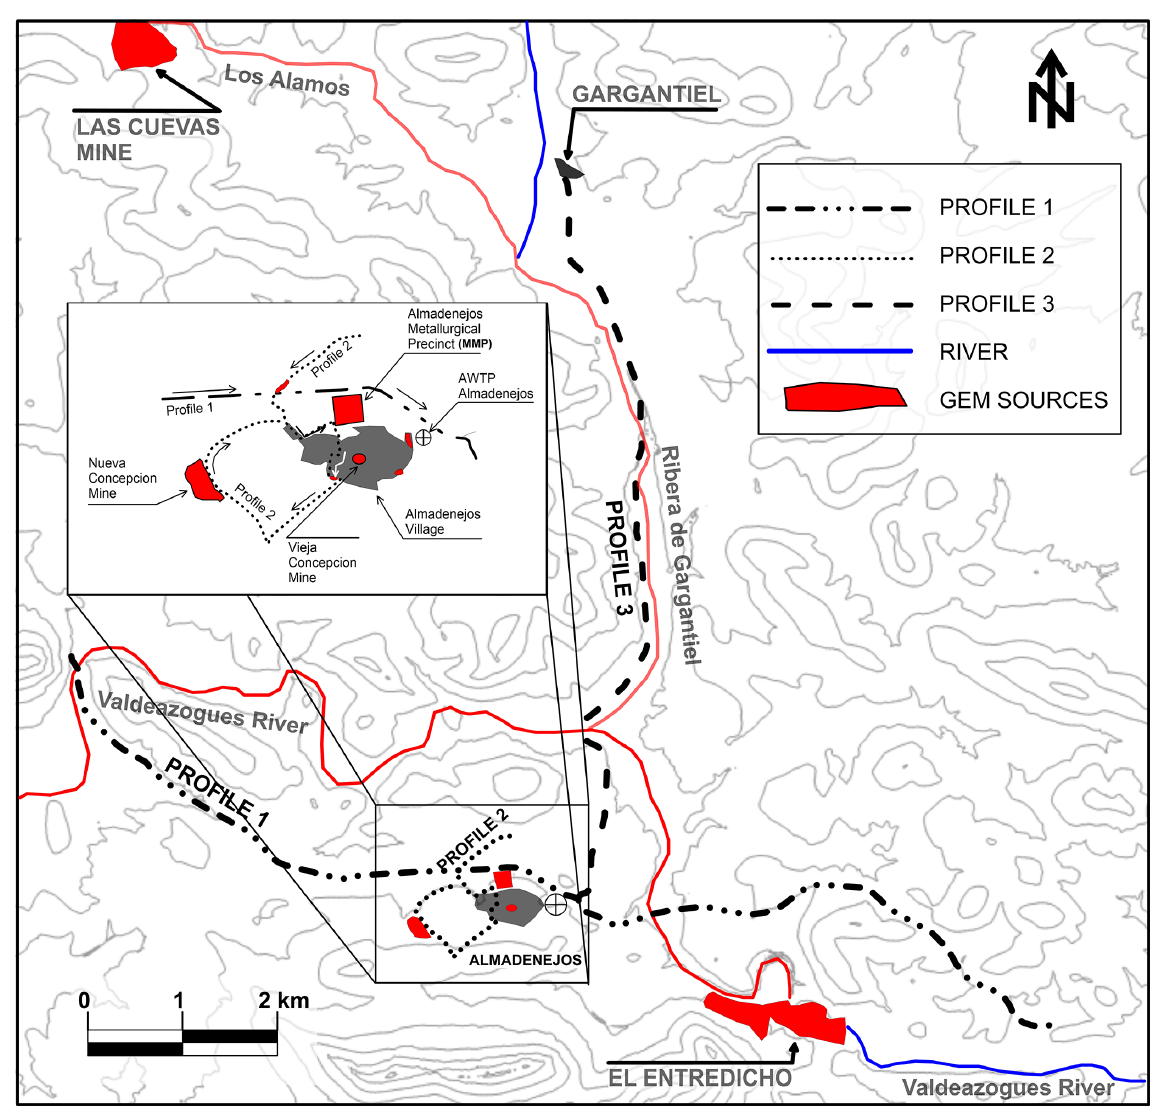
Figure 1. Location of the three horizontal profiles in the study area and main mercury mining sites. AWTP: Almadenejos wastewater treatment plant. Main known gaseous mercury sources are shown in red (including rivers with Hg-contaminated sediments); uncontaminated streams are shown in